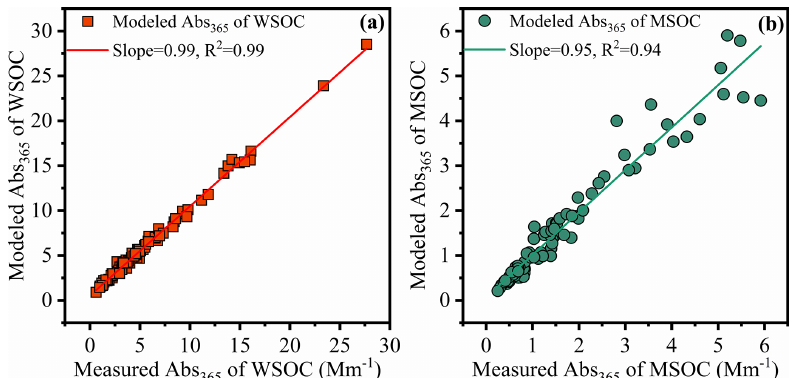
Figure 5. Linear correlation analysis between modeling Abs 365 using multiple linear regression (MLR) analysis and measured Abs 365 in the water-soluble organic carbon (WSOC, a ) and methanol-soluble organic carbon (MSOC, b ) in aerosols samples from Bangkok in Thailand during 2016–2017, respectively. Note that the fluorescent intensities of parallel factor (PARAFAC) model results (fluorescent components) were used as variables in MLR analysis.